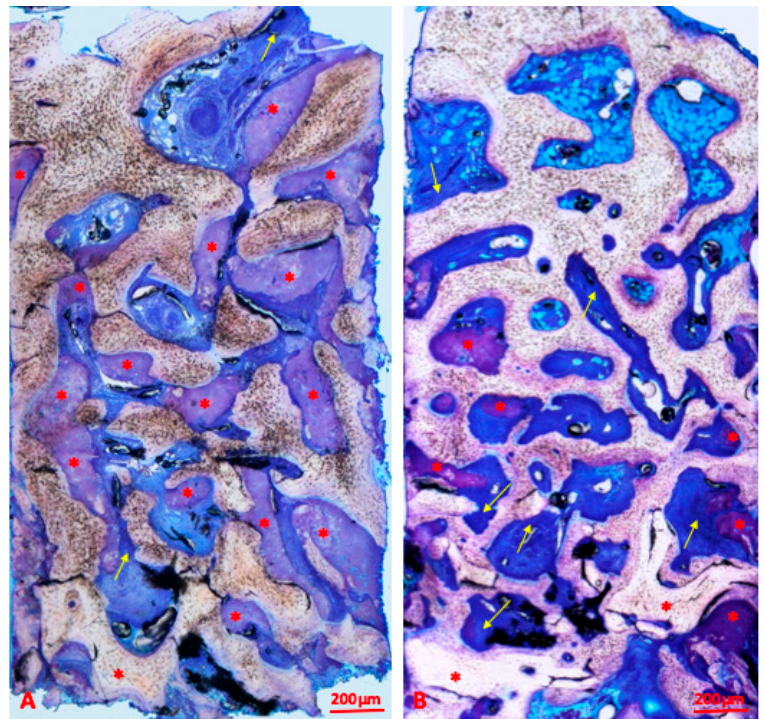
Figure 4. Overview of samples of the xenograft enriched by polymer and gelatin (NBS) group (bar scale = 200 microns). Red asterisks are placed on polymers and blocks of biomaterials while yellow arrows indicate osteoid matrix on the borders of the bony trabeculae. The residual biomaterial is stained in violet and is in close contact with newly formed lamellar bone at different phases of mineralization. New bone is organized in thick trabeculae interconnected among them. ( A ) and ( B ) present differences in biomaterial amount; biomaterial is more represented in ( A ) than in ( B ). Toluidine blue and pyronine yellow staining.